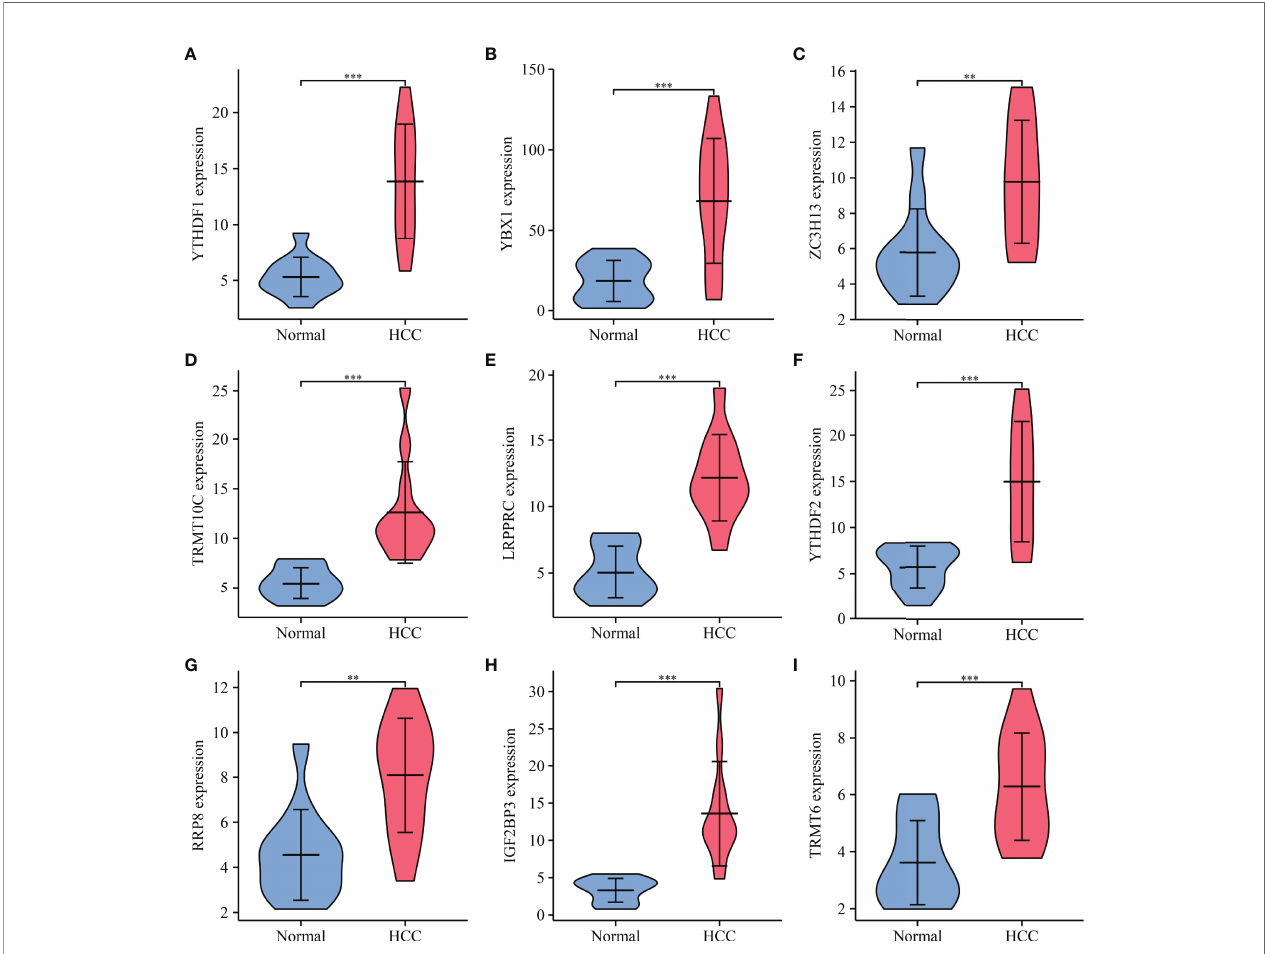
FIGURE 6 | The expression pro fi le of risk model genes in HCC tissues. (A) YTHDF1; (B) YBX1; (C) ZC3H13; (D) TRMT10C; (E) LRPPRC; (F) YTHDF2; (G) RRP8; (H) IGF2BP3; (I) TRMT6. HCC, hepatocellular carcinoma; **P < 0.01; ***P <